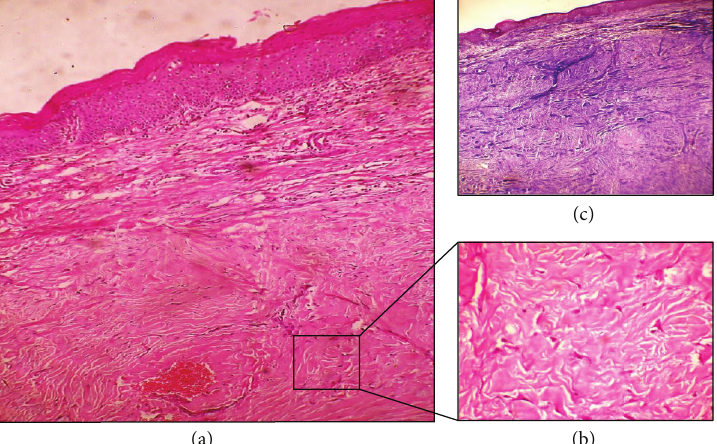
Figure 3: (a) H & E, 4x: well demarcated lesion with a capsule and areas of hyalinization. (b) H & E, 40x: numerous plump fibroblasts. (c) Masson trichrome, 4x: positive for